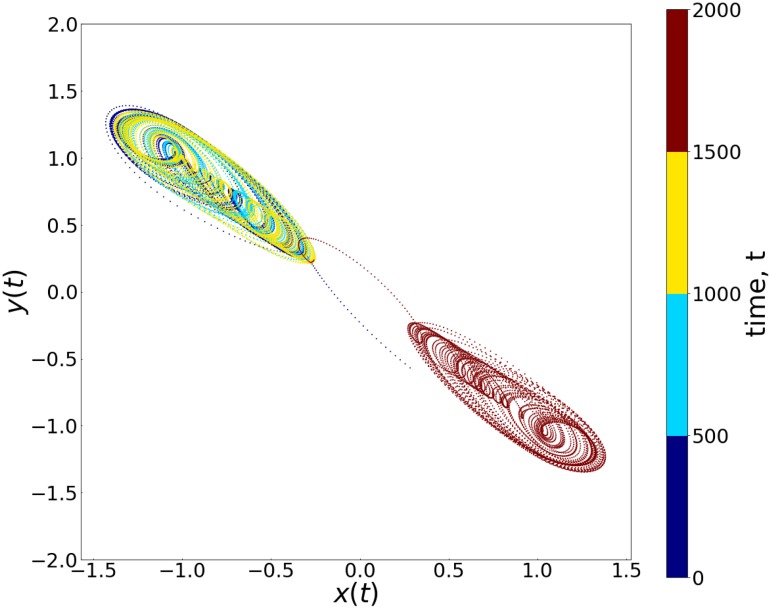
Phase portraits of the dynamical attractors arising from the different input sets in Fig 2 (with a = 1.015, c1 = −0.55, c2 = −1.02, A = 0.11, ω = 0.74 in Eq 1).Here the time evolution under different input sets is depicted in different colors. It is clearly evident that the trajectory switches between chaotic attractors in two distinct quadrants as the logic input sets change, yielding appropriate output states.